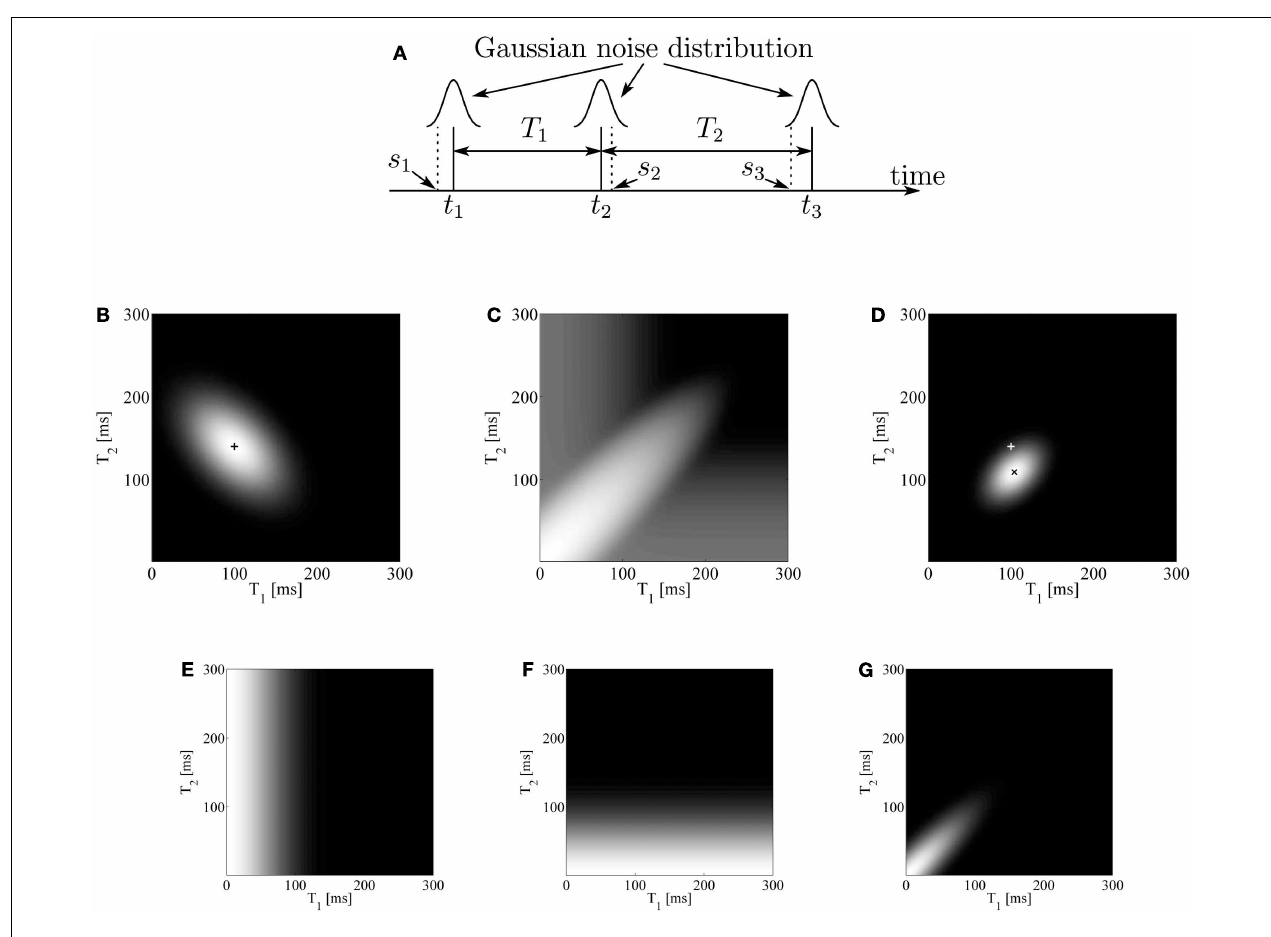
both axes as well as along the 45˚ line from the T 1 -axis. (D) Posterior distribution of ( T 1 , T 2 ) given observed values of S 1 = 100ms and S 2 = 140ms (indicated as “ + ”). Intensity indicates probability.The cross sign ( × ) corresponds to the peak of the distribution. (E–G) Prior distributions of ( T 1 , T 2 ) given that (E) the first and second sounds come from the same source, (F) the second and third sounds come from the same source, and (G) all three sounds come from the same source. Intensity indicates